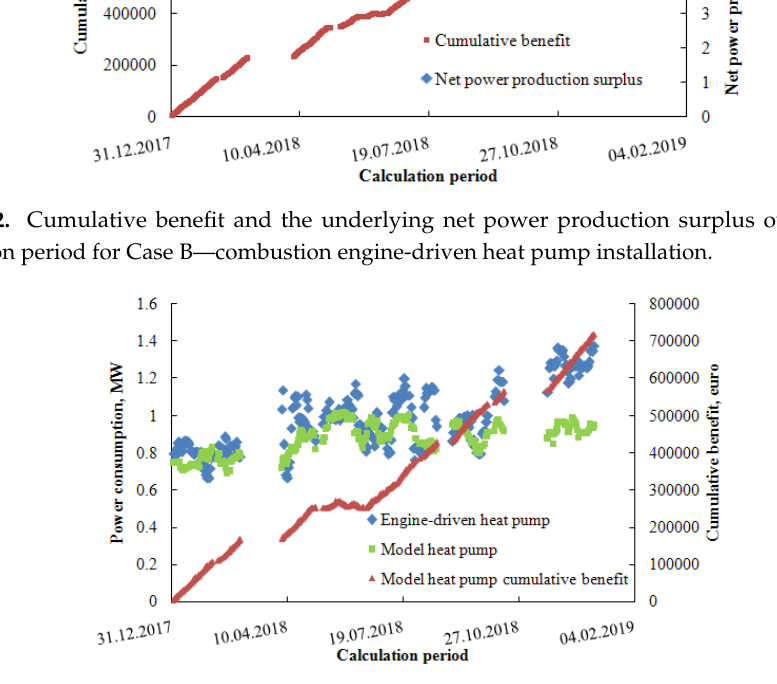
Figure 13. Cumulative benefit for the model heat pump installation and a comparison of the power consumption for the model and the engine-driven heat